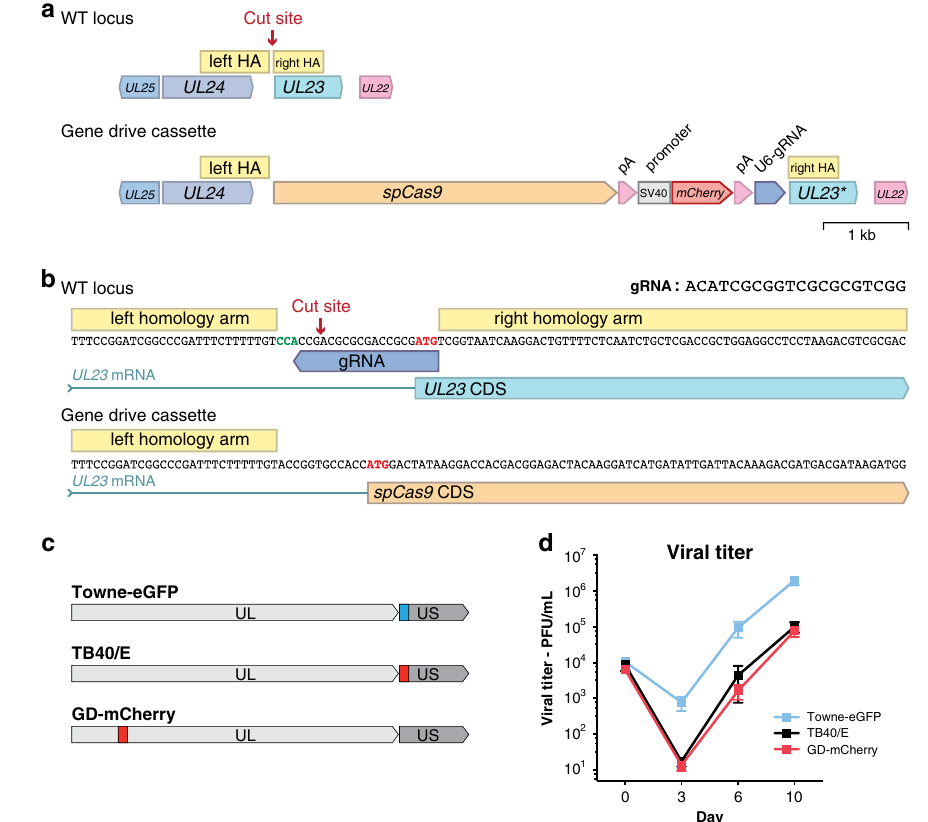
Fig. 2 Design of a gene drive system targeting hCMV UL23 . a Modi fi ed and unmodi fi ed UL23 locus. Here, the gene drive cassette is composed of spCas9 followed by the SV40 polyA signal, an SV40 promoter driving an mCherry reporter, the beta-globin polyA signal and a U6-driven gRNA. b UL23 CRISPR cutting site and sequence of WT and modi fi ed viruses. spCas9 transcription is driven by UL23 viral promoter. CDS: coding sequence. c Localizations of mCherry and eGFP cassette on hCMV genomes. UL/US: unique long/short genome segments. d Replication of Towne-eGFP, TB40/E, and GD-mCherry viruses. Viral titers were measured by plaque assay over time. Titers are expressed in plaque forming unit (PFU) per mL of supernatant. Error bars represent standard error of the mean (SEM) between biological replicates. n = 5 (TB40/E), or n = 8 (Towne-eGFP and GD-mCherry). Source data are provided as a Source Data fi